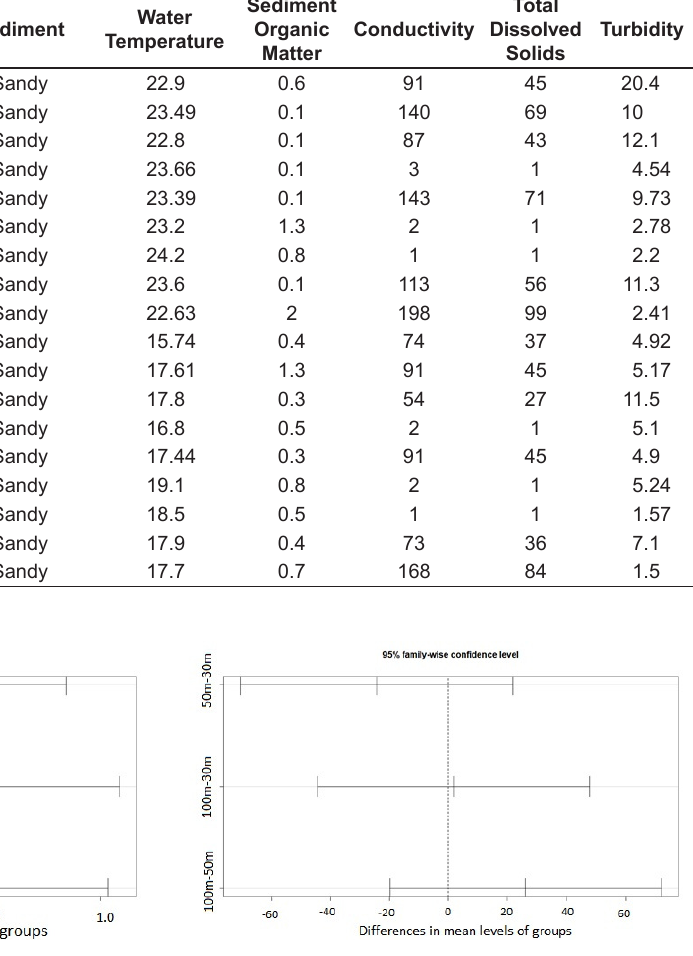
Figure 4. Post-hoc Tukey HSD test results of Total Dissolved Solids (mg/l) in the water column between riparian zone width categories.